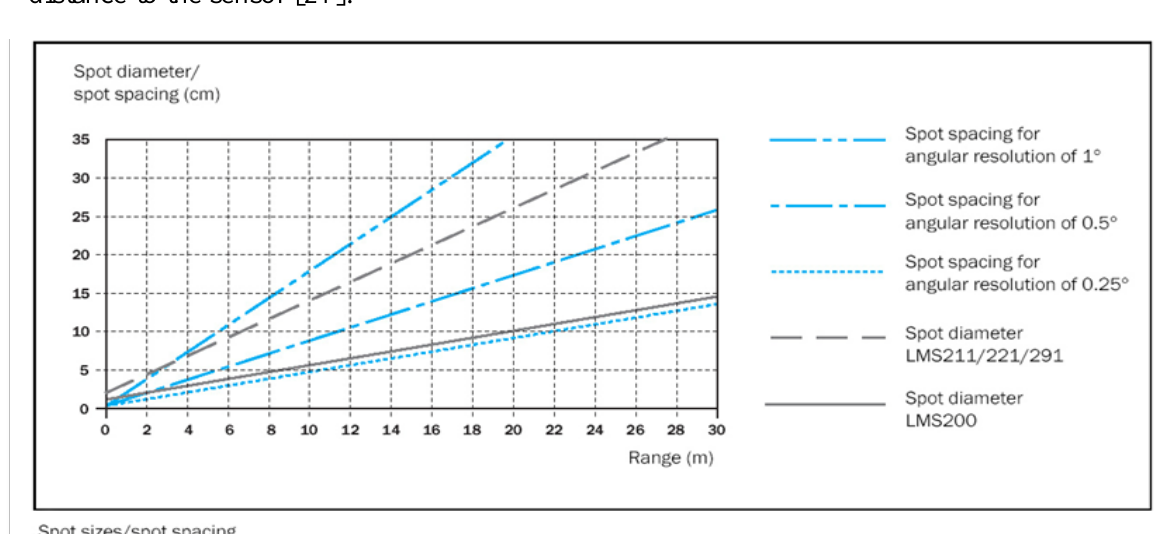
Figure 2. Diameter of the laser beam cross-section of various models of the SICK LMS series and the separation between beams as a function of the angular resolution and distance to the sensor [21].